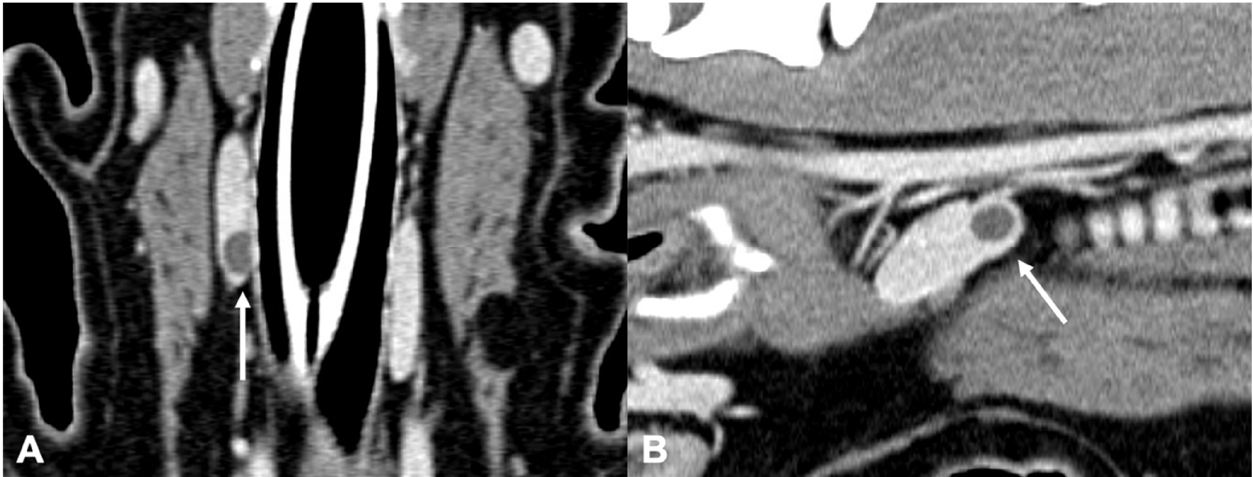
Figure 6. CT appearance of parathyroid gland hyperplasia. Post-contrast dorsal ( A ) and right parasagittal ( B ) CT reconstruction of one dog with parathyroid gland hyperplasia (arrow) at the level of the right internal parathyroid. The parathyroid is ovoid-shaped and homogeneously contrast-enhancing. Note the marked difference in attenuation between the parathyroid (hypoattenuating) and the adjacent thyroid tissue.